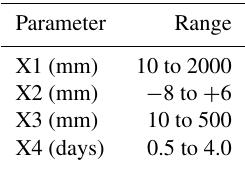
Table 2. Ranges of GR4J parameters used for parameter calibration (Demirel et al.,